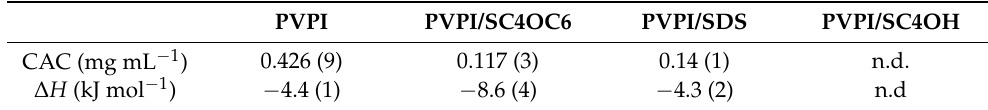
Table 1. Critical aggregation concentration (CAC) and enthalpy of aggregation ( ∆ H) values for the povidone iodide (PVPI) self-aggregation process in different media at 25 ◦